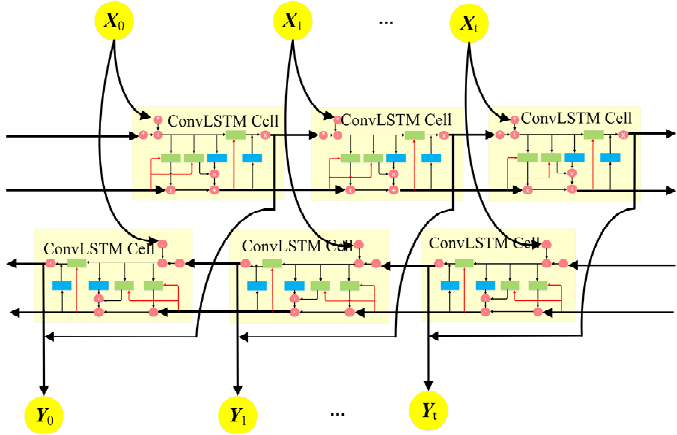
Figure 5. Bidirectional ConvLSTM network structure.